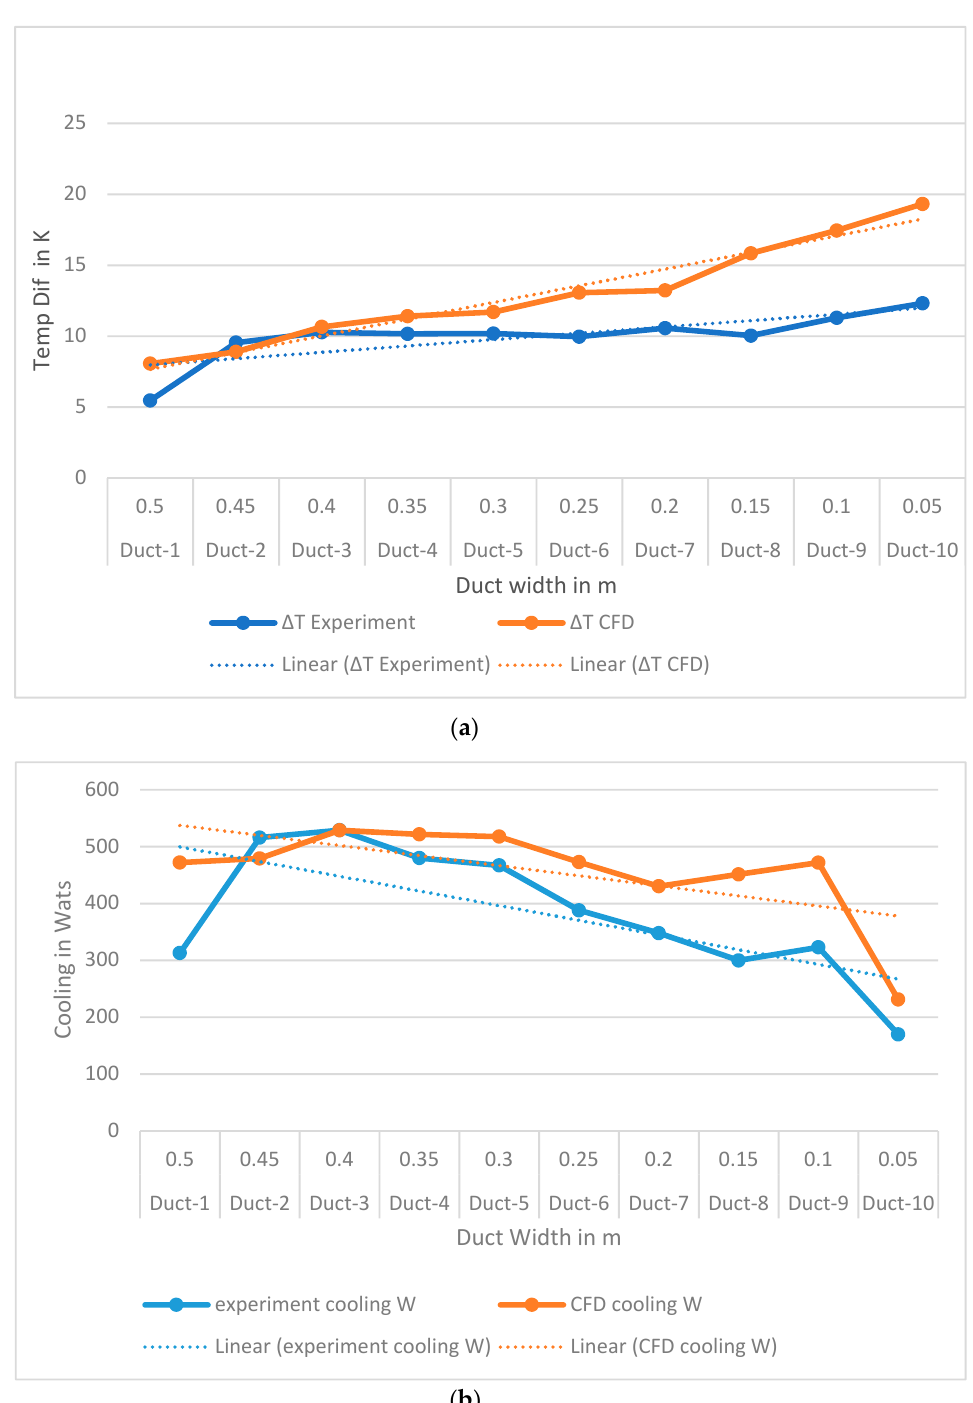
Figure 5. ( a ) Comparison between the experimental and simulated results of the mean cell temperatures; ( b ) plots of the average air temperature from the inlet to the outlet of the duct for all duct widths simulated .